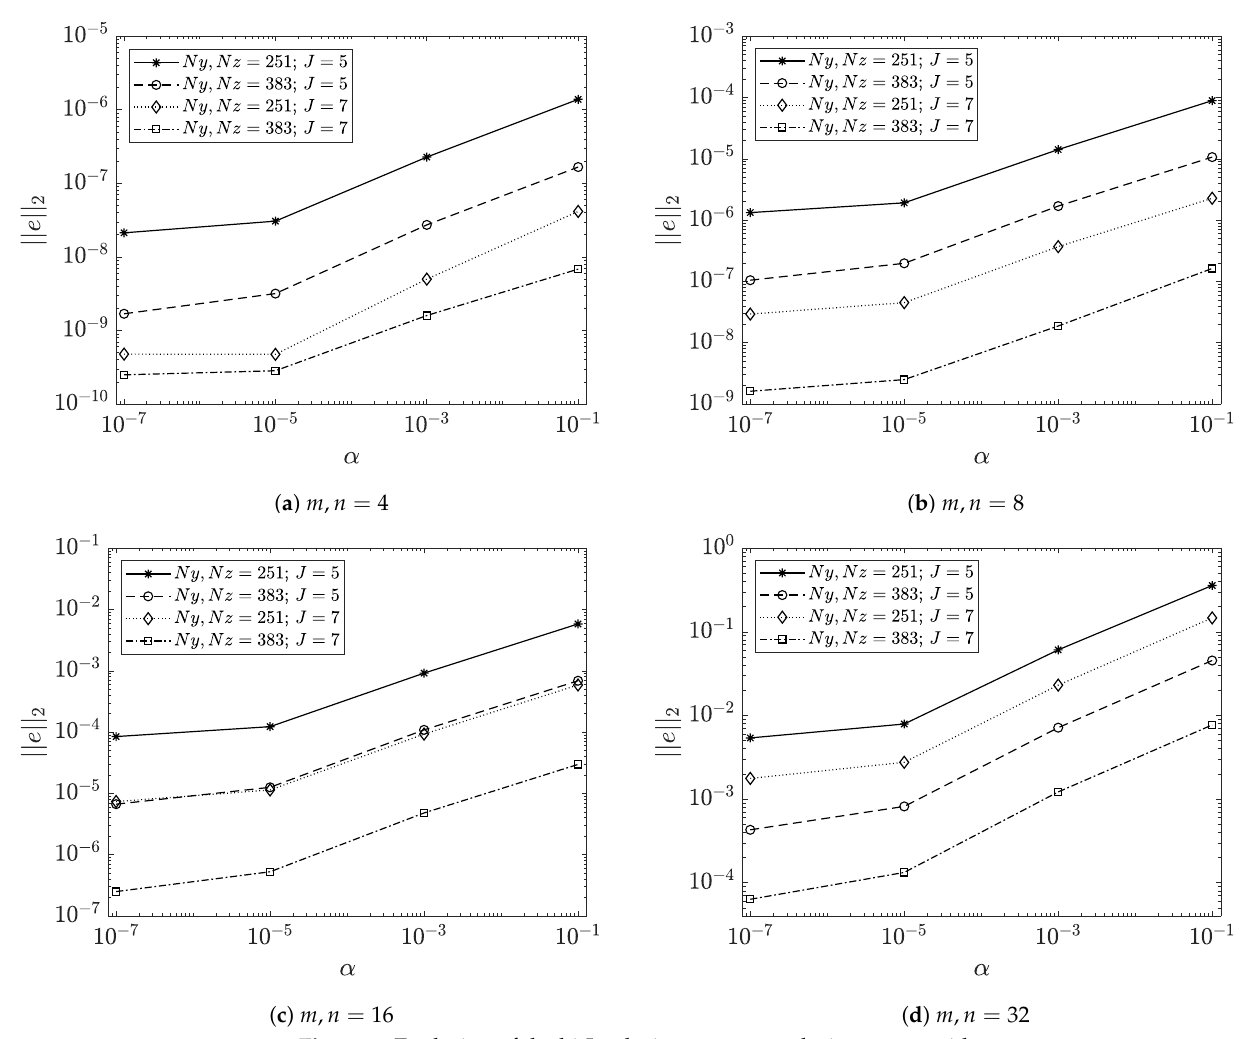
Figure 3. Evolution of the bi-Laplacian operator solution errors with α